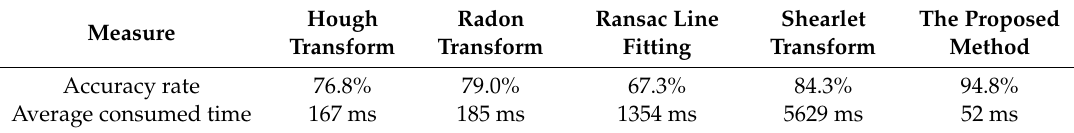
Table 1. SSL detection result comparison of different methods on the benchmark